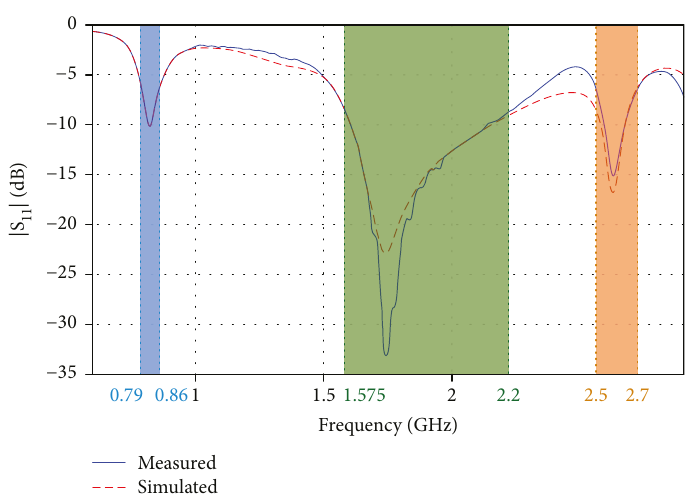
∣ parameters for the proposed DRA. 11